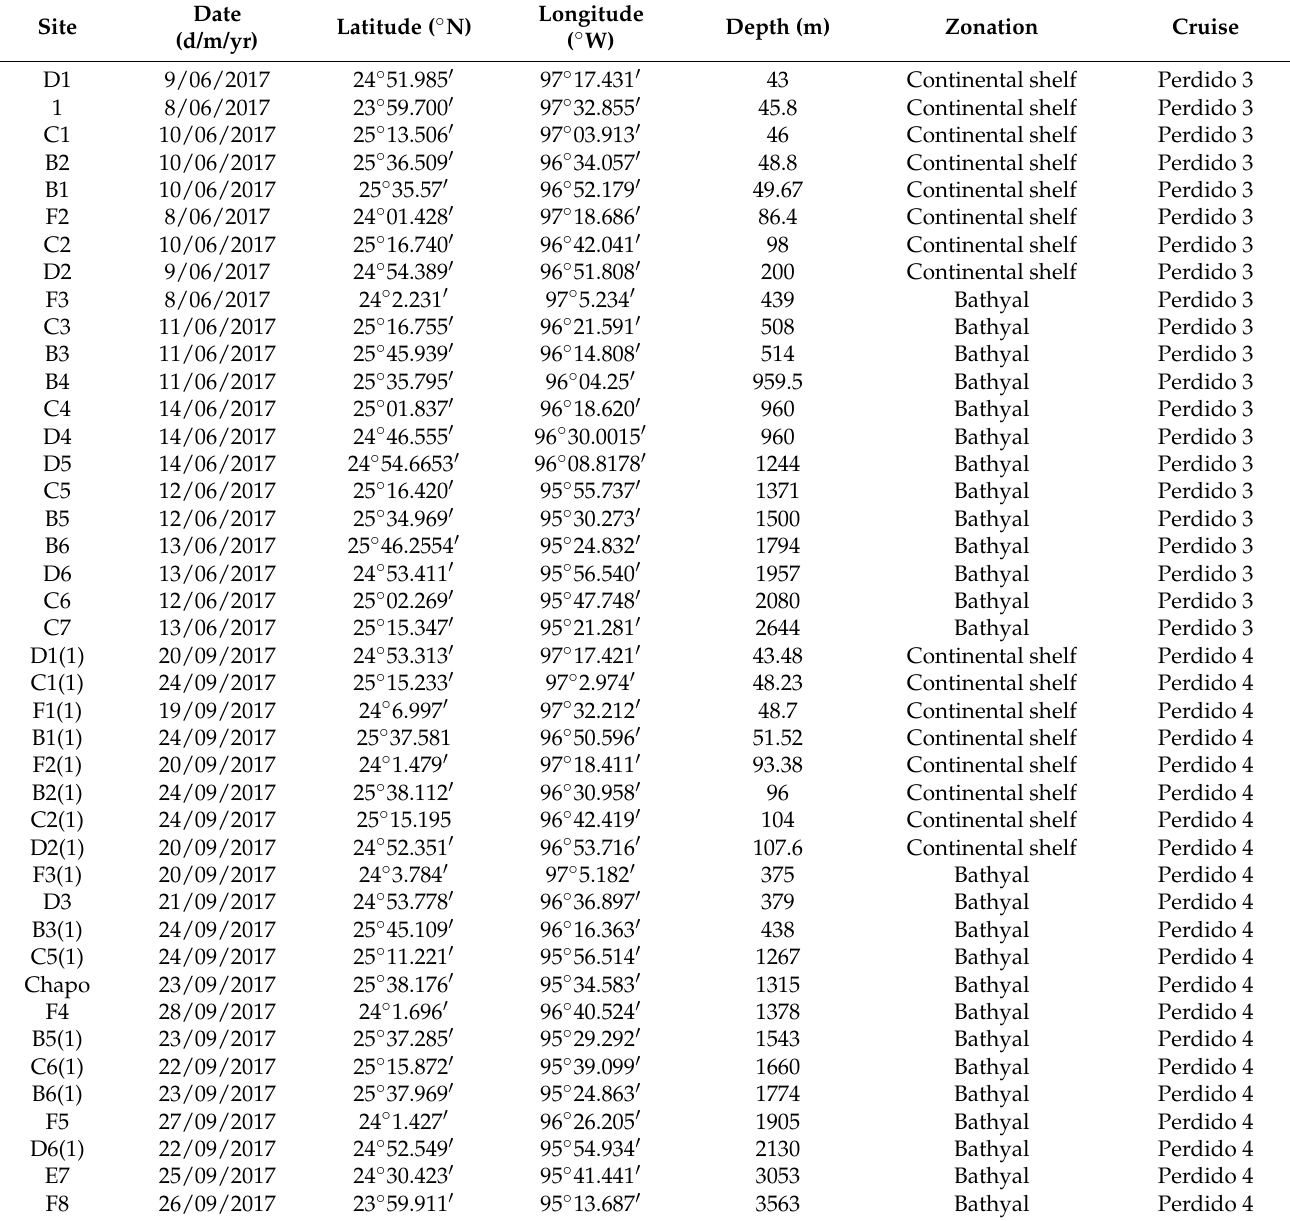
Table 1. Sampling locations where bivalves were collected in the Perdido Fold Belt, Gulf of